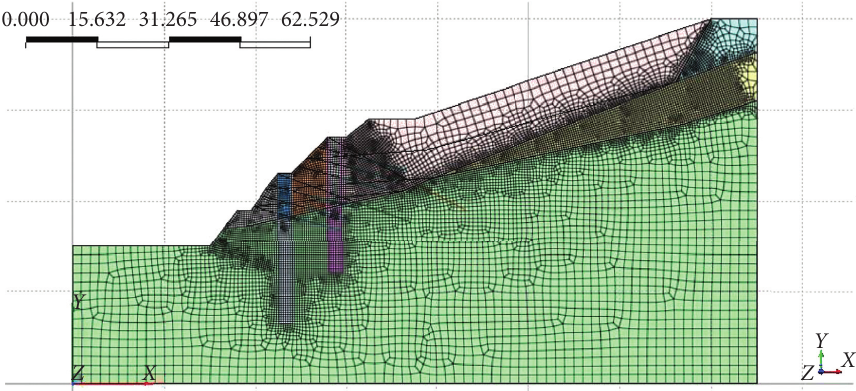
Figure 4: Mesh model diagram of the K5+ 420 slope